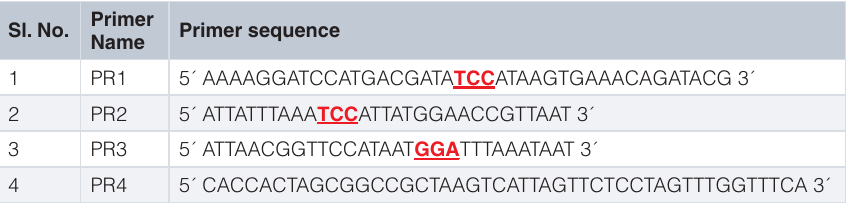
Table 1. Oligonucleotide primer pairs for the PCR amplification of Hos2 gene by SOE